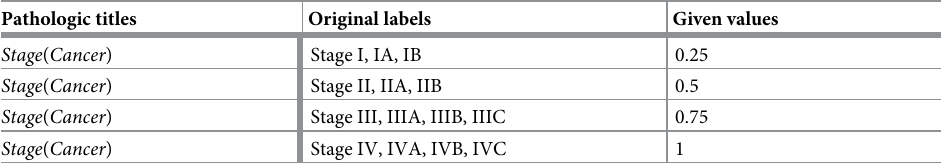
Table 1. The sample discrete value table of TCGA clinical-stage data.